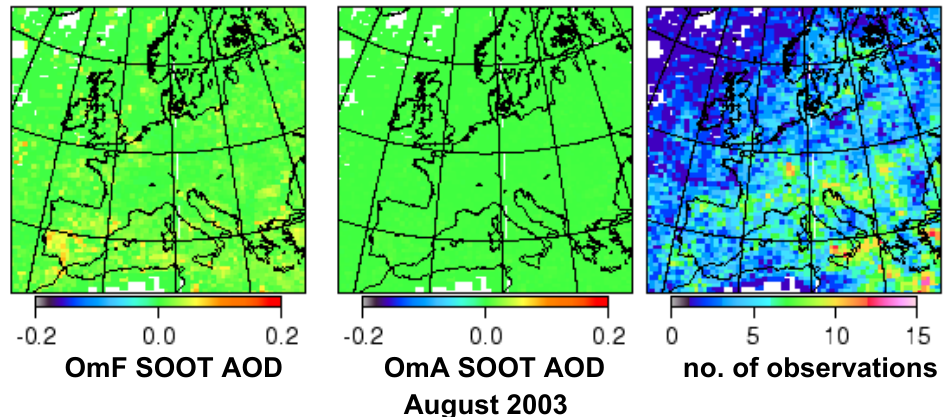
Fig. 4. Map of SOOT component differences for observations minus forecast (left), observations minus analysis (middle) and number of observations used for each EURAD grid box in August 2003 (right). The wild fire induced signal in the observations is visible over the Iberian Peninsula and North of Algeria (yellow and orange color) and disappears in the analysis field (green colors indicating OmF and OmA around zero).